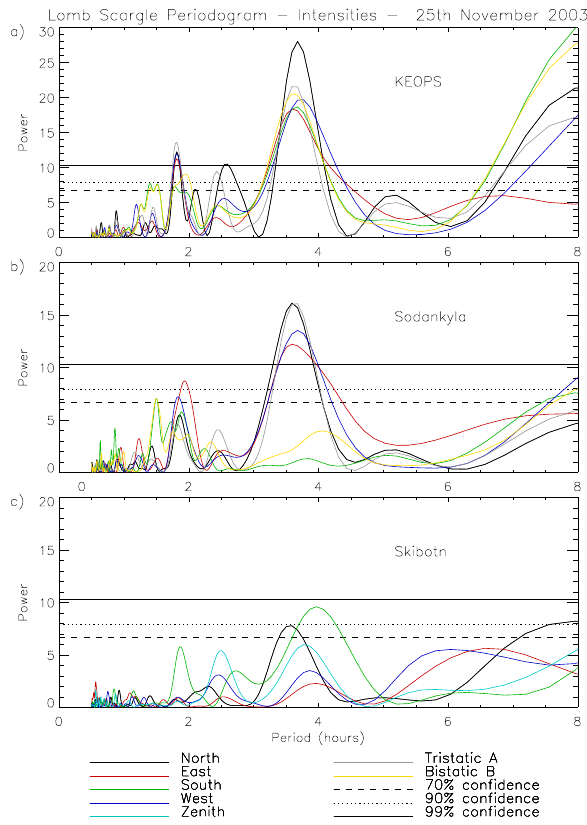
Fig. 4. Lomb-Scargle periodograms for (a) KEOPS (b) Sodankyl¨a and (c) Skibotn FPI intensities on the 25 November 2003. Colours represent the different look directions observed, and horizontal lines are 70%, 90% and 99% confidence